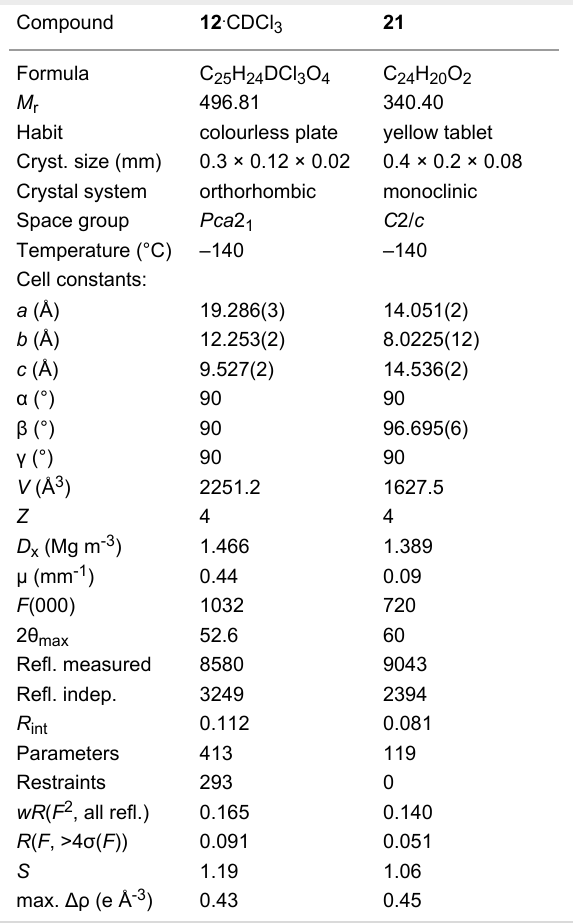
Table 2: Crystallographic data for 12 . CDCl 3 and 21